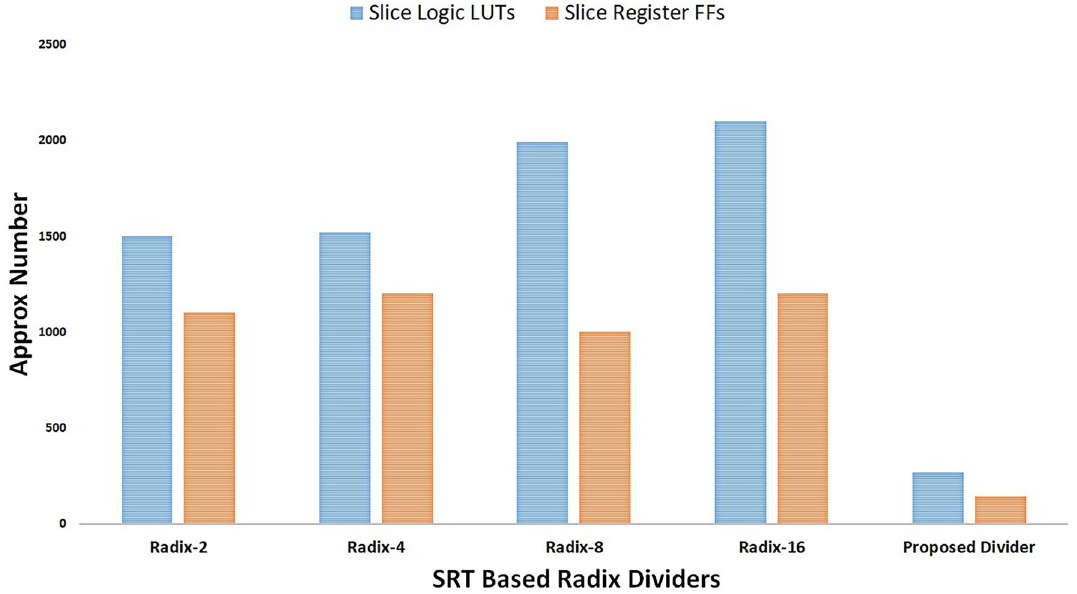
Figure 10. Comparative analysis regarding the hardware resource utilization of the proposed USP-Awadhoot algorithm-based divider and radix-n-based